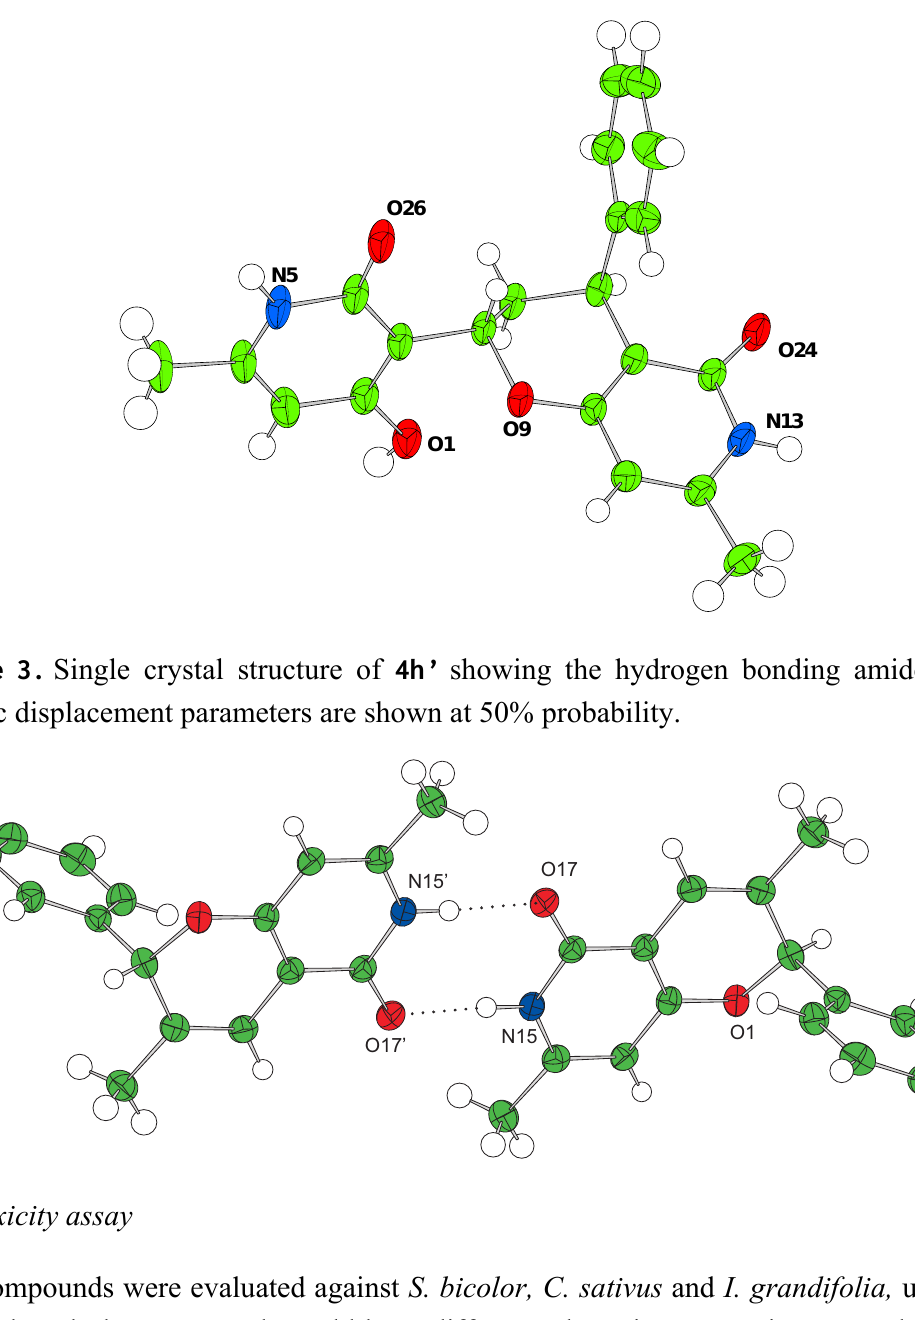
Figure 2. Single crystal structure of compound 4g’ . Atomic displacement parameters shown at 50% probability, one equivalent and the disordered DMSO are omitted for clarity.